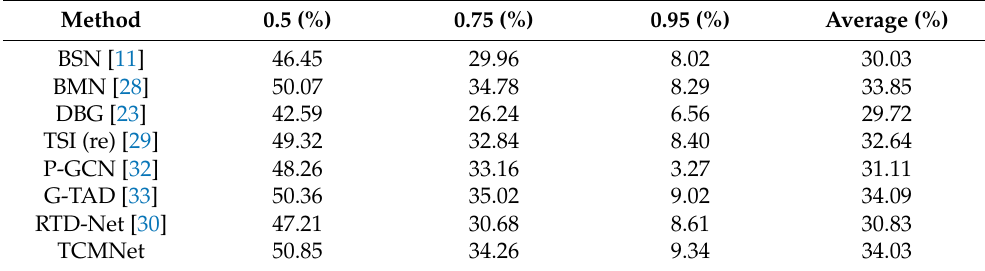
Table 6. Temporal action detection results on the validation set of the ActivityNet-1.3 in terms of mAP at different tIoU thresholds. “re” denotes that this method is re-implemented by ourselves.